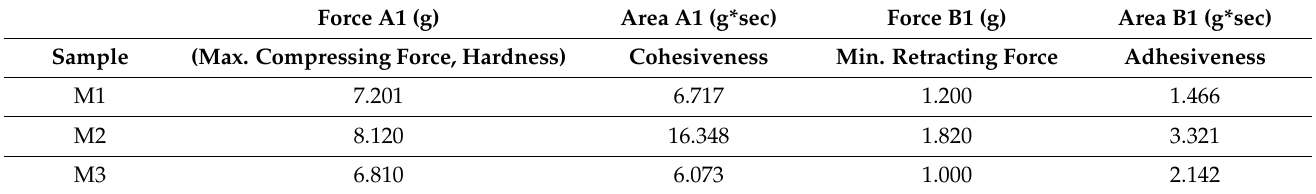
Table 2. Texture properties of the hydrogel formulations under the optimized test